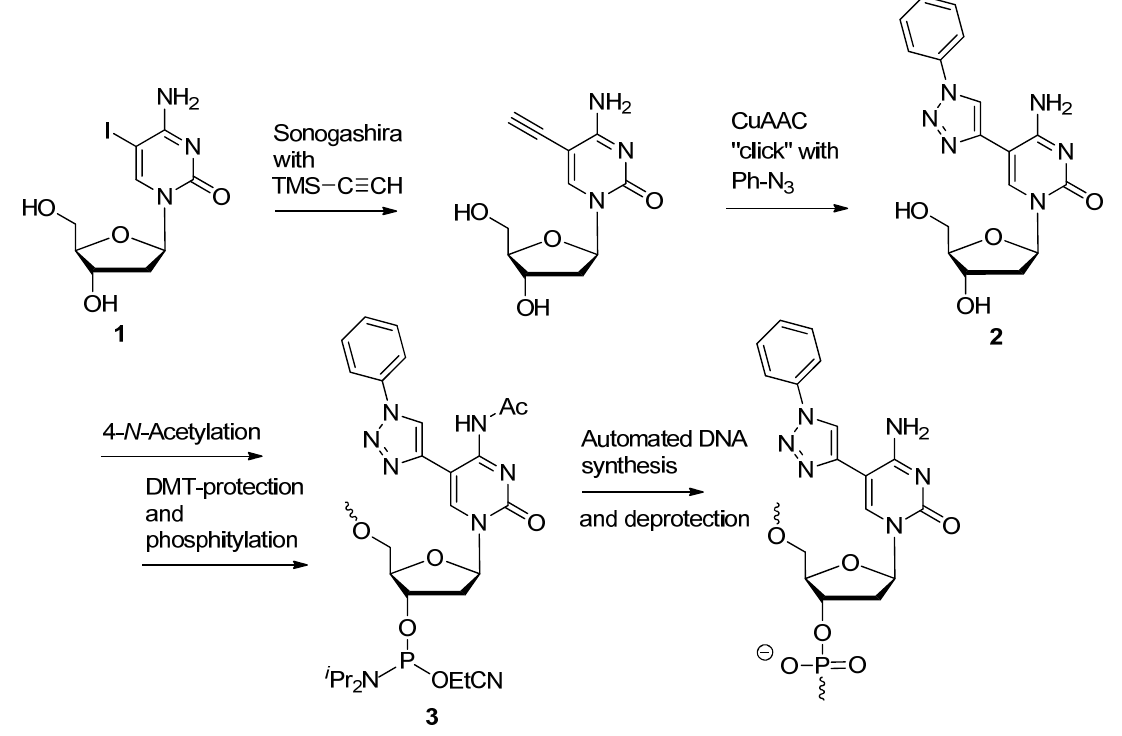
Figure 1. Example compounds used for ASO and siRNA-based